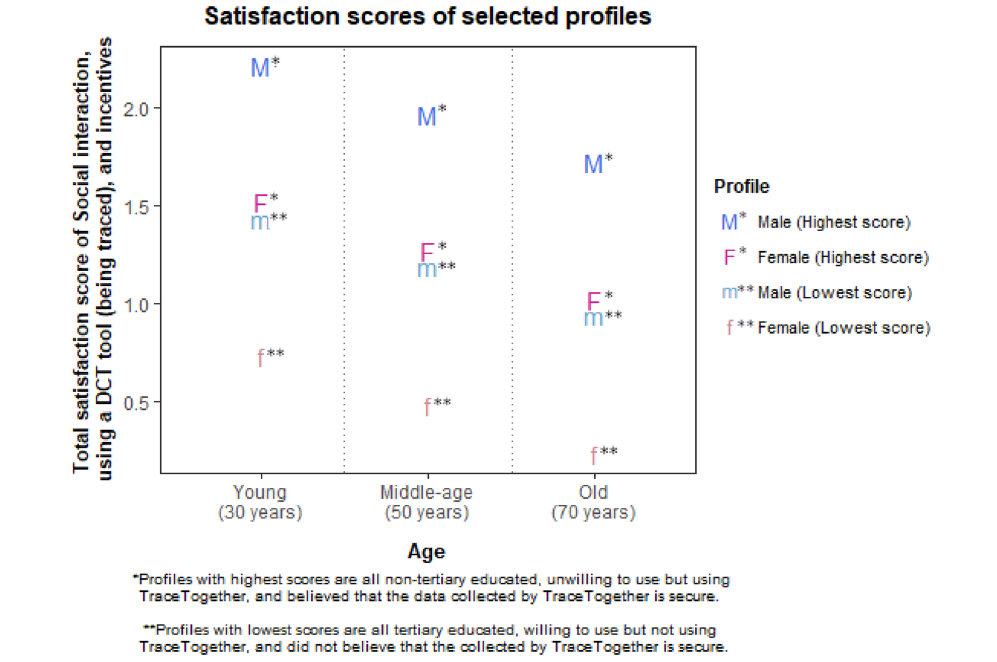
Figure 1. Highest and lowest total satisfaction scores for social interactions and incentives while being traced by a DCT tool, by age and gender #